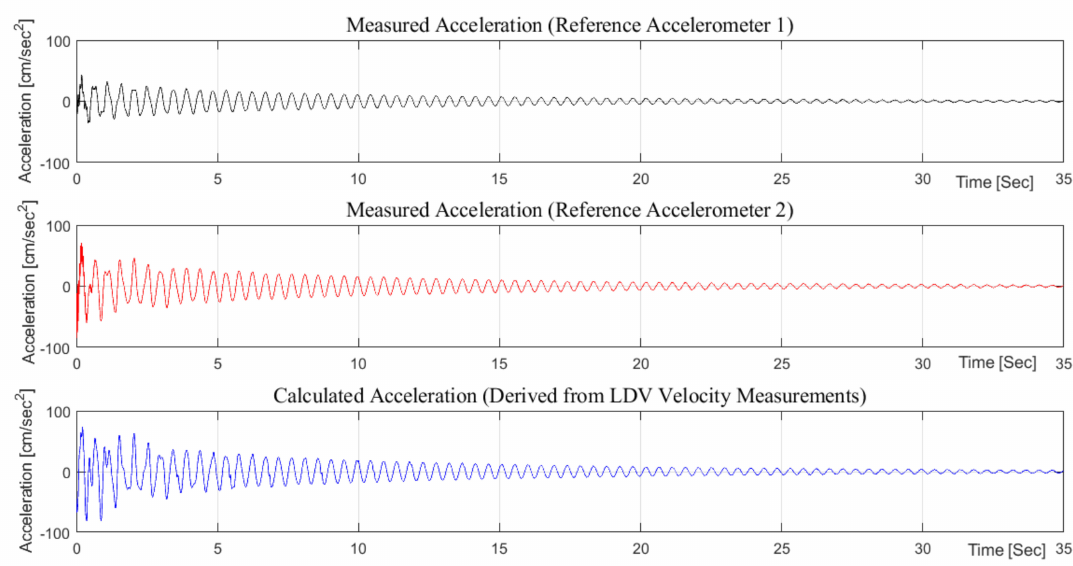
Figure 3. Comparison of the vibration data recorded by accelerometers and